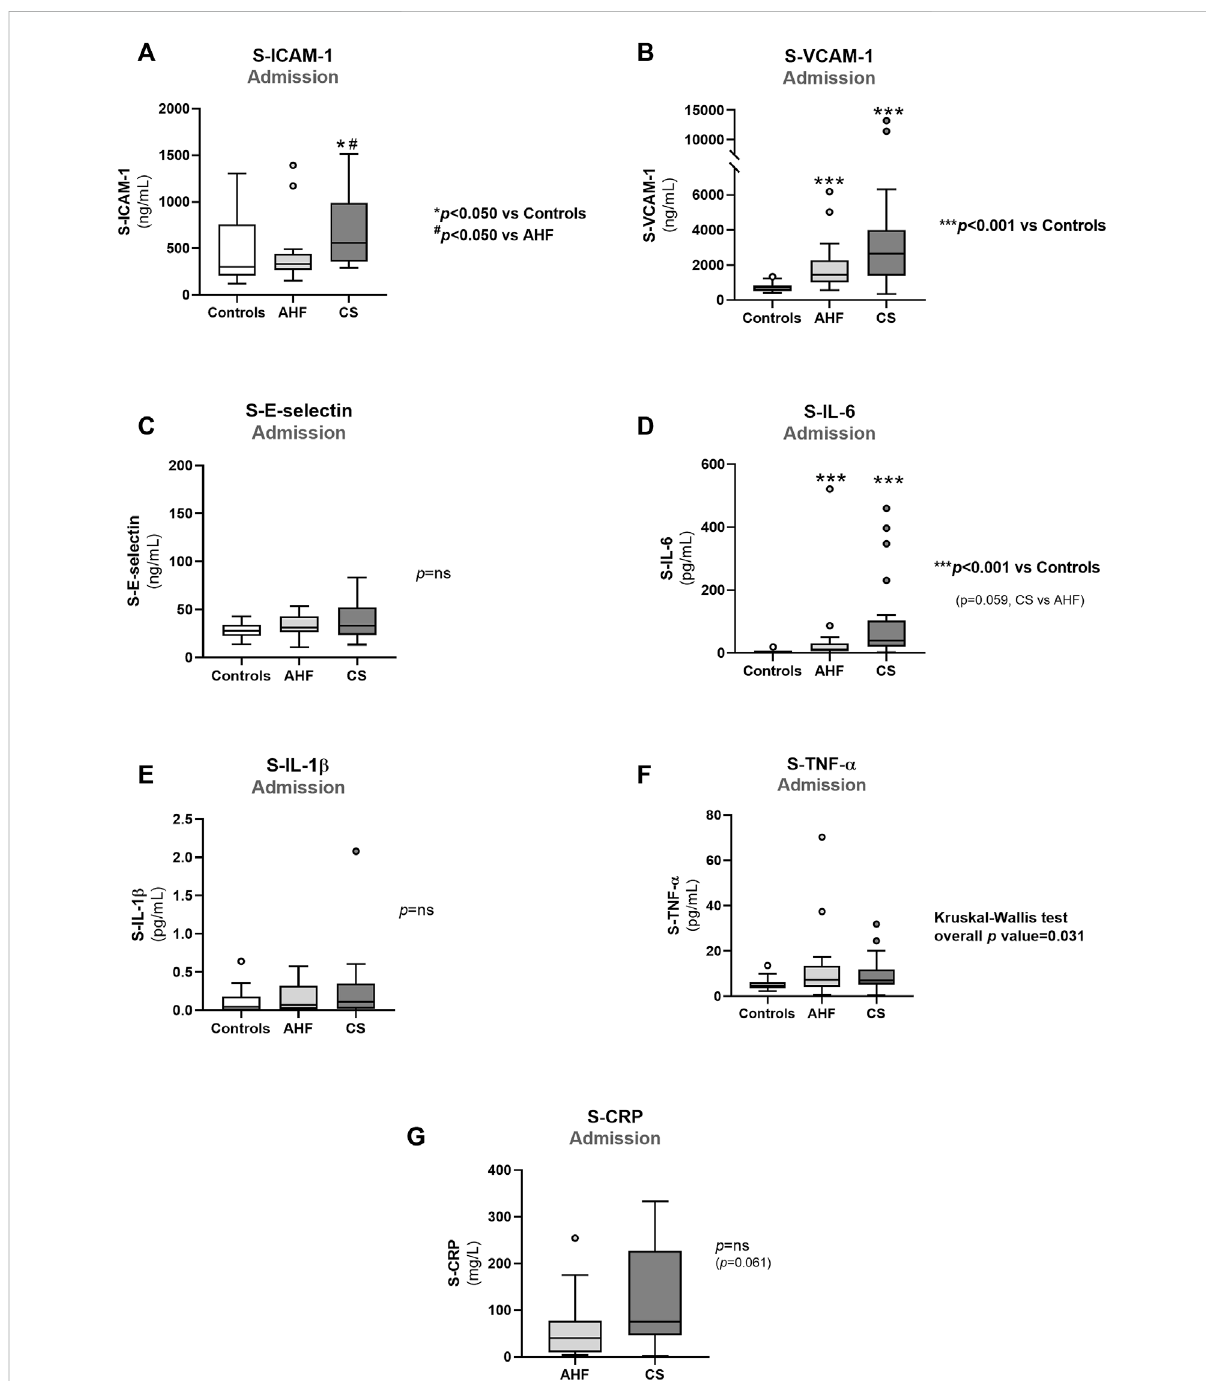
FIGURE 3 Admission values of biomarkers of endothelial dysfunction and in fl ammation in controls, AHF and CS: (A) S-ICAM-1; (B) S-VCAM-1); (C) S-E-Selectin; (D) S-IL-6; (E) S-IL-1 β ; (F) S-TNF- α ; (G) S-CRP. Results are presented in Box-and-Whiskers plot. AHF, acute heart failure; CS, cardiogenic shock; S-CRP, serum C-reactive protein; S-E-Selectin, serum E-Selectin; S-ICAM-1, serum intercellular adhesion molecule 1; S-IL-1 β , serum interleukin 1 β ; S-IL-6, serum interleukin 6; S-TNF- α , serum tumour necrosis factor alpha; S-VCAM-1, serum vascular cell adhesion molecule